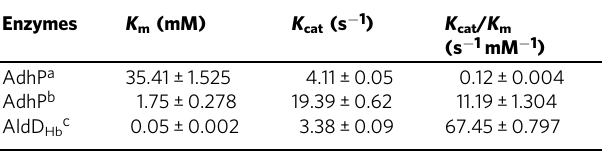
Each value represents the mean ± standard deviation in triplicate experiments. a Assayconditions:100mMpotassiumcarbonate buffer(pH9.0)containing30mMammonium sulfate; 2mM, NAD + ; 9.7 μ g mL − 1 , AdhP; 1,3-propanediol concentration was varied from 1.17 to 600mM; temperature was set at 37°C. b Assay conditions: 50mM Tris-HCl buffer (pH 7.0) containing 0.1mM NADH; 0.36 μ g mL − 1 , AdhP; 3HPA concentration was varied from 0.01 to 20mM; temperature was set at 37°C.